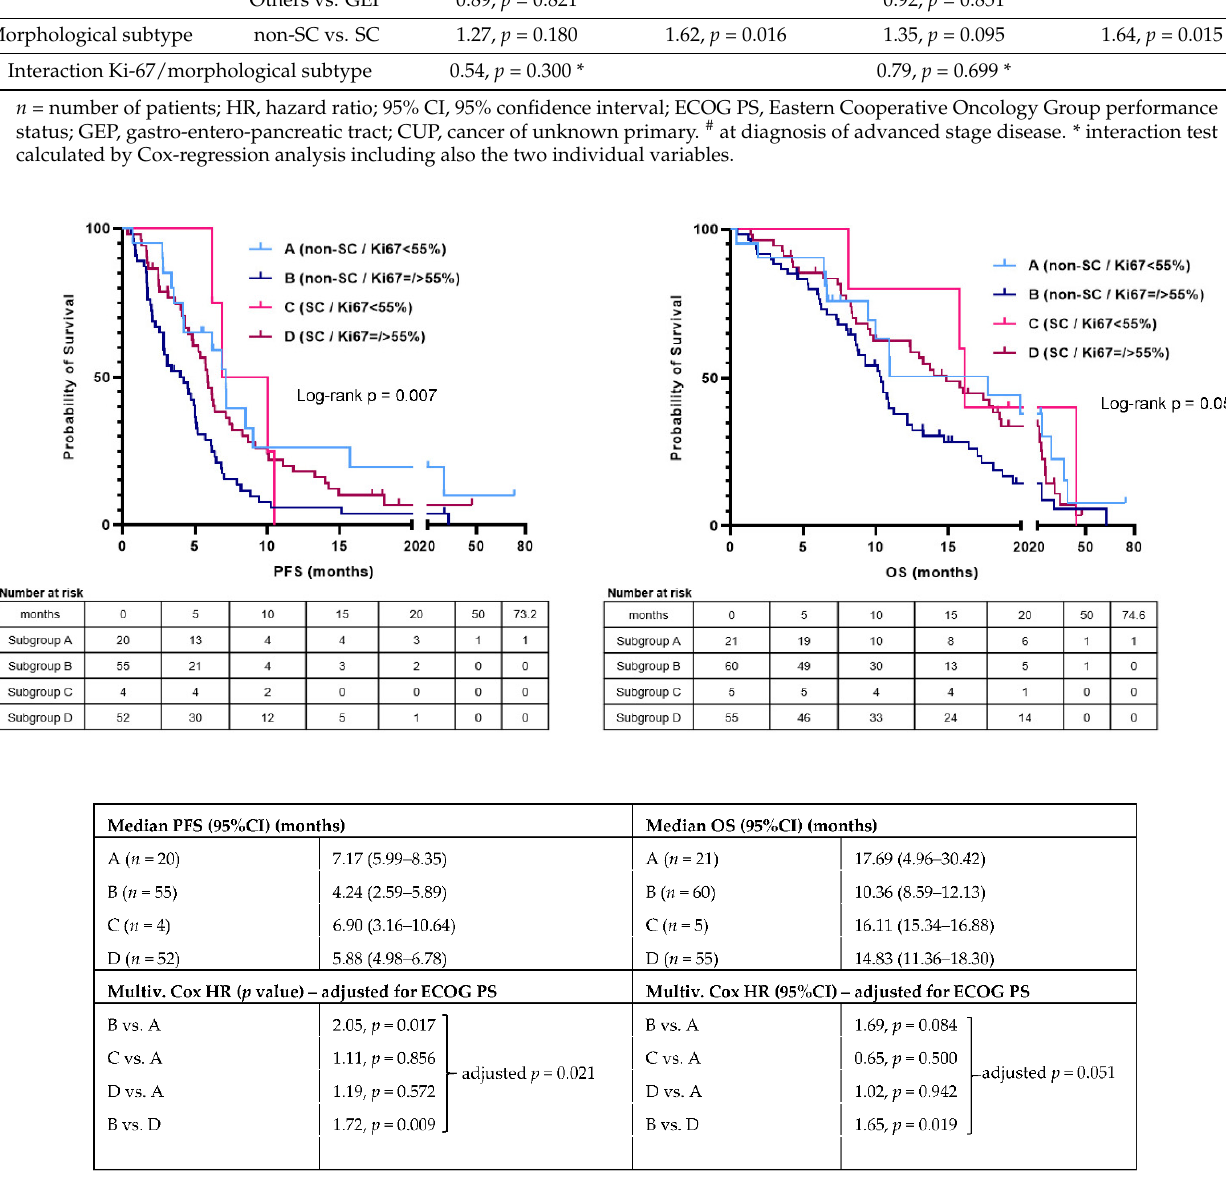
Figure 4. Kaplan–Meier analysis for PFS and OS according to subgroups per morphological subtype and Ki-67 index (<55% vs. ≥ 55%) in patients with advanced-stage extra-pulmonary neuroendocrine carcinoma in this study. n = number of patients; 95% CI, 95% confidence interval; ECOG PS, Eastern Cooperative Oncology Group performance status.